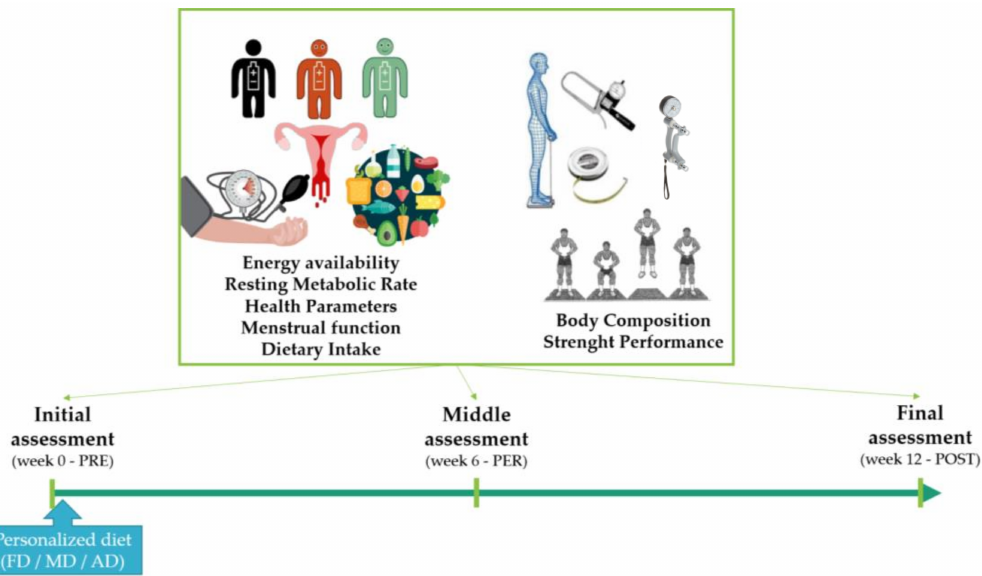
Figure 1. Study Design. F.D: free diet group; MD: Mediterranean diet experimental group; AD: antioxidant diet experimental group; PRE: before intervention; PER: during intervention; POST: after